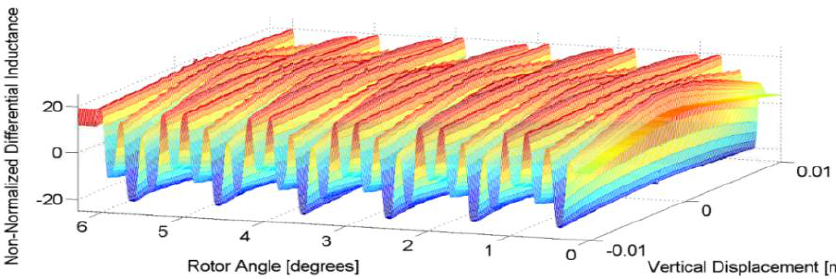
Figure 6. Differential inductance calculated using the dynamic AFSRM